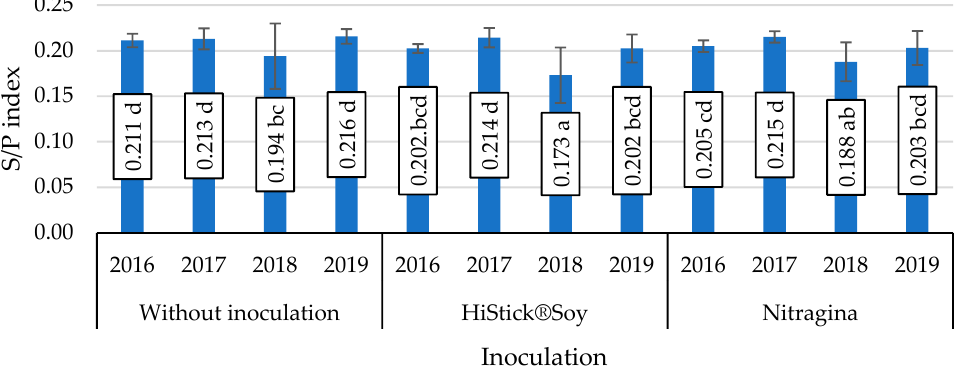
ferences ( p < 0.05) according to the post-hoc Tukey test. Differences significant at: *** p < 0.001.